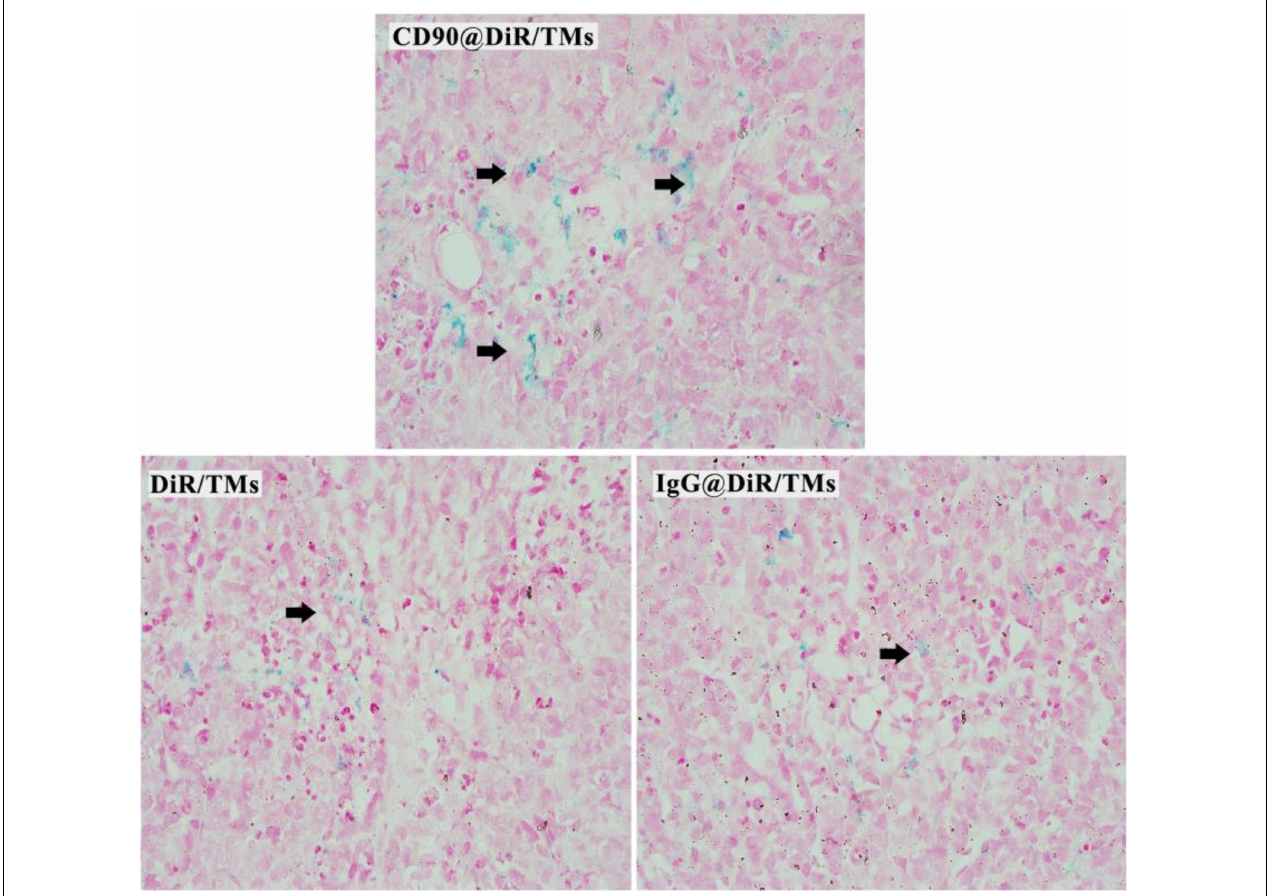
FIGURE 3 | Prussian blue staining of the tumor tissues injected with DiR/TMs and CD90@DiR/TM ( × 40).